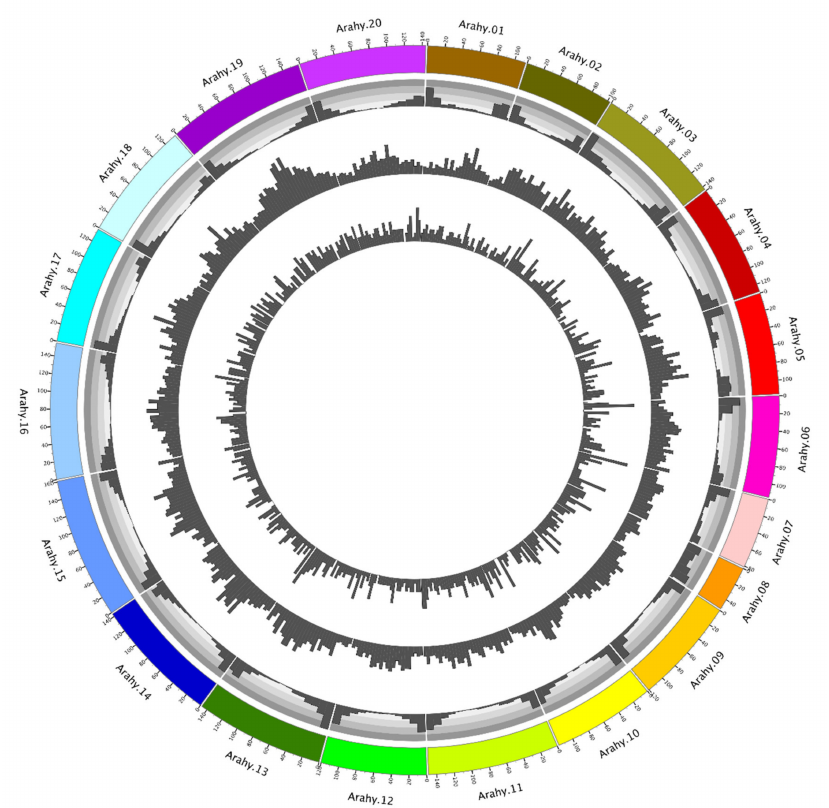
Figure 1. Genome map of peanut. The four layers from the outmost to the innermost, respectively, represent chromosomes, gene density, SNP density, and InDel